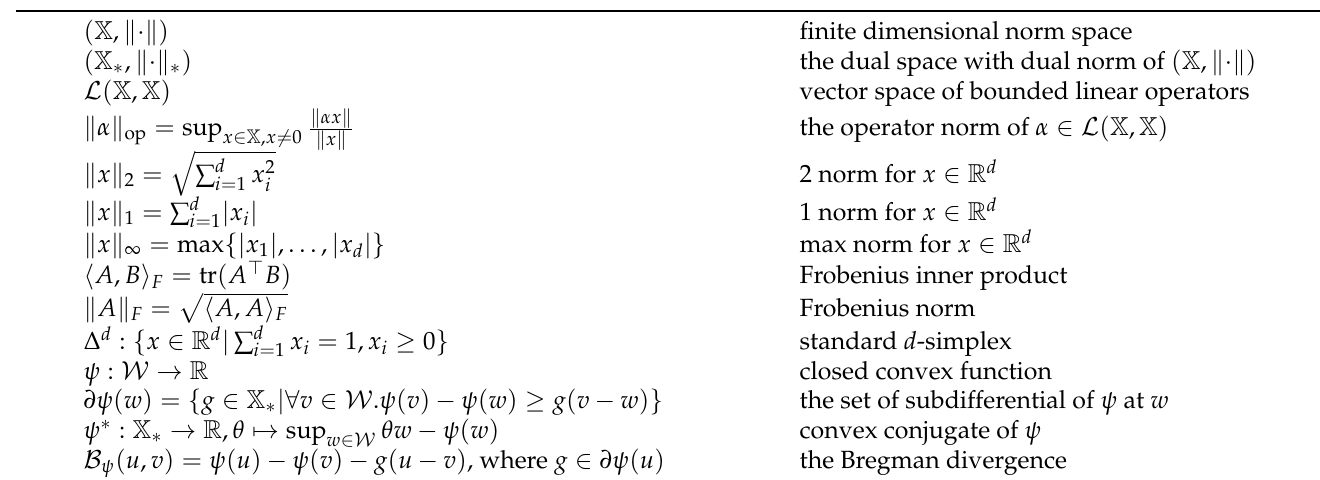
Table A1. Nomenclature.